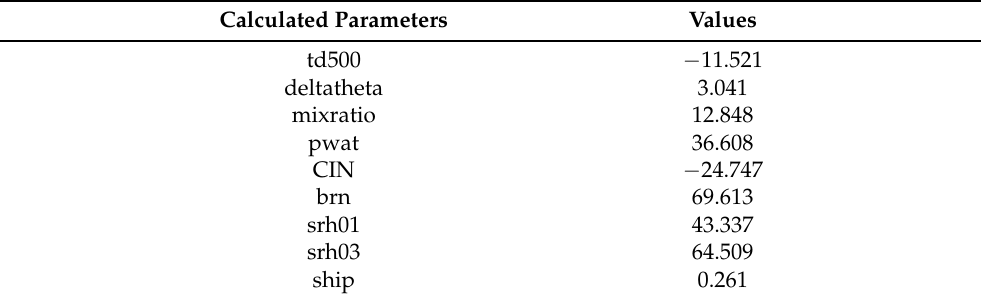
Table 3. Numerical values of calculated parameters obtained through the customized